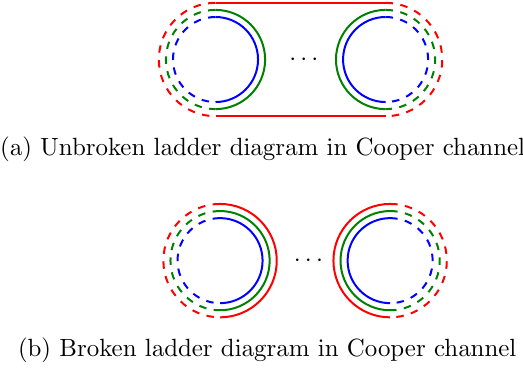
Figure 16. Unbroken and broken ladder diagram in Cooper channel. The dashed line represents contraction of external gauge